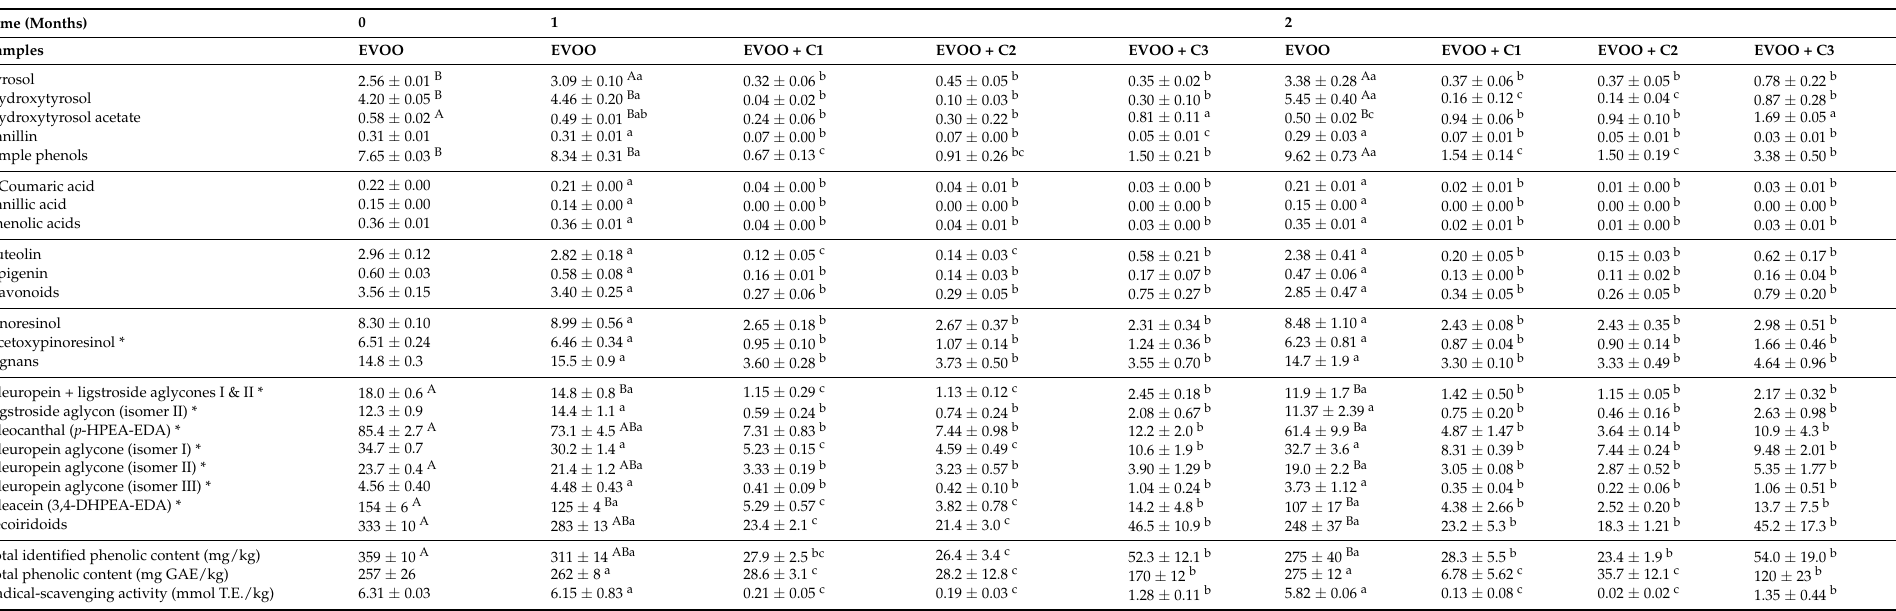
Table 4. Concentration of phenolic compounds (mg/kg), total phenolic compounds, and values of radical-scavenging activity in extra virgin olive oil (EVOO) during storage with and without the addition of semi-hard (C1), hard (C2), and soft whey (C3)